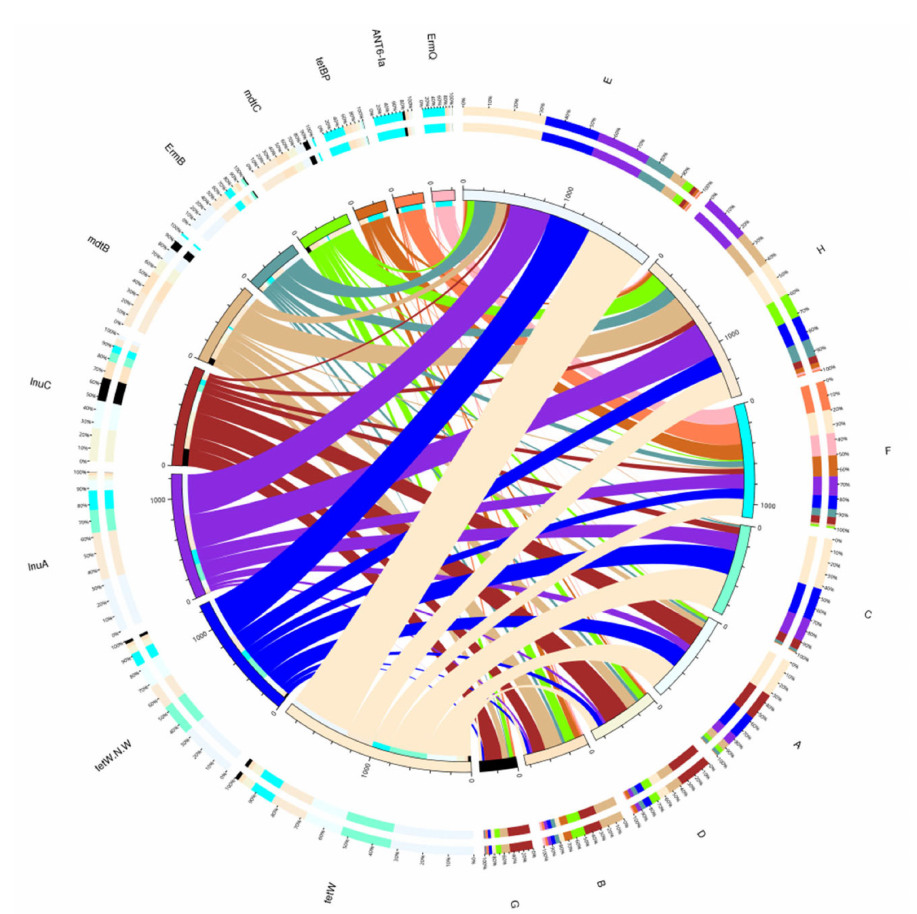
Figure 14. Overview circle of resistance genes. The circle diagram is divided into two parts, with sample information on the right and ARO information on the left; Different colours in the inner circle represent different samples and AROs. The scale is the relative abundance, in ppm. The left side is the sum of the relative abundances of each ARO in a sample, and the right side is the sum of the relative abundances of each ARO in a sample. The left side of the outer ring is the relative percentage of each sample in an ARO, and the right side of the outer ring is the relative percentage of each ARO in a